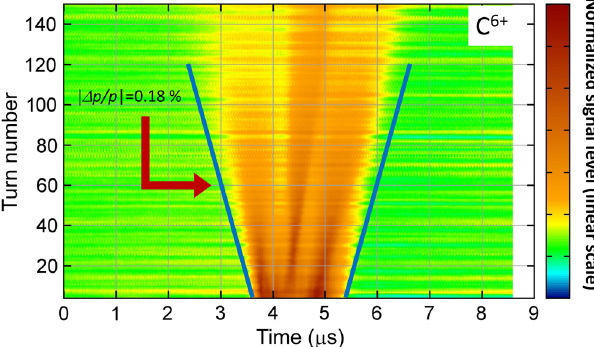
FIG. 5. Time-turn plane view of the free run of C 6 þ , where some fine structures are visible. This fine structure in time of the beam pulse profile is known to be attributed to effects of the residual voltage ringing of the ES injection kicker